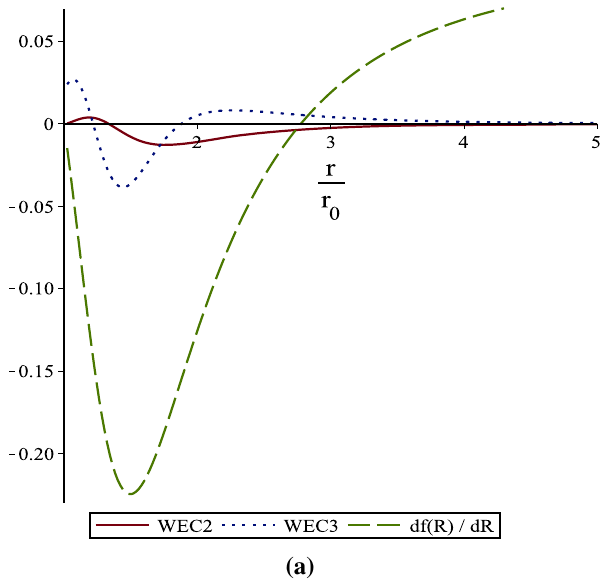
Fig. 3 Setting n = 2 . 8in a , we canseethat df ( R )/ dR < 0 around the throatandtheobtainedwormholesolutionofHu–Sawickimodelrespect NEC at r 0 . The blue region in b corresponds to traversable asymptoti-